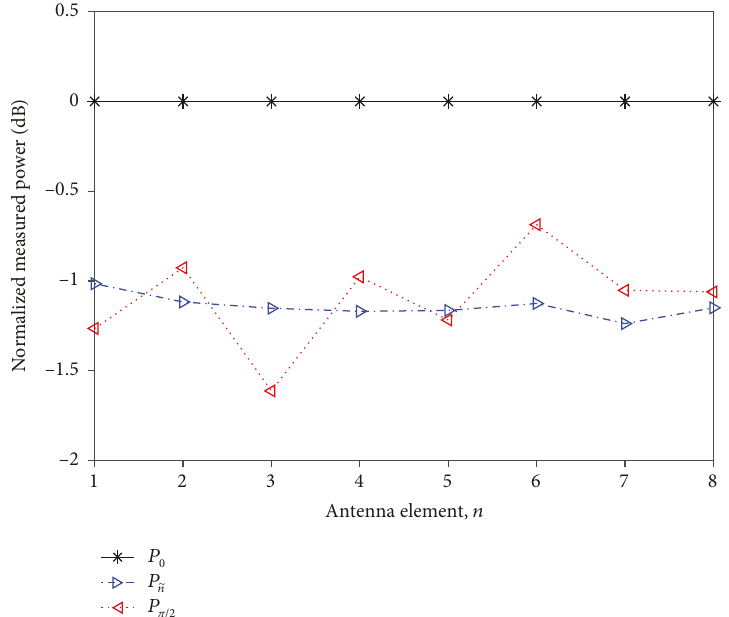
Figure 4: The normalized power measurement